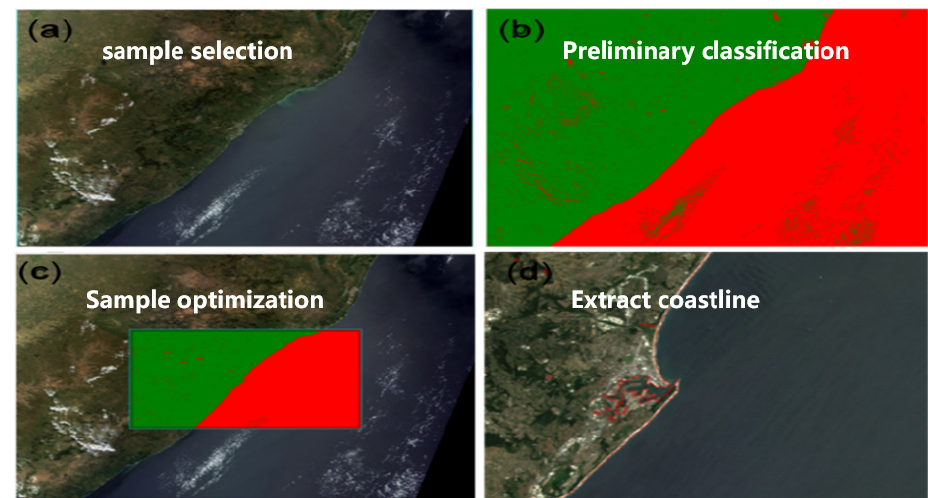
Figure 13. Coastline extraction of Durban geometric calibration field.